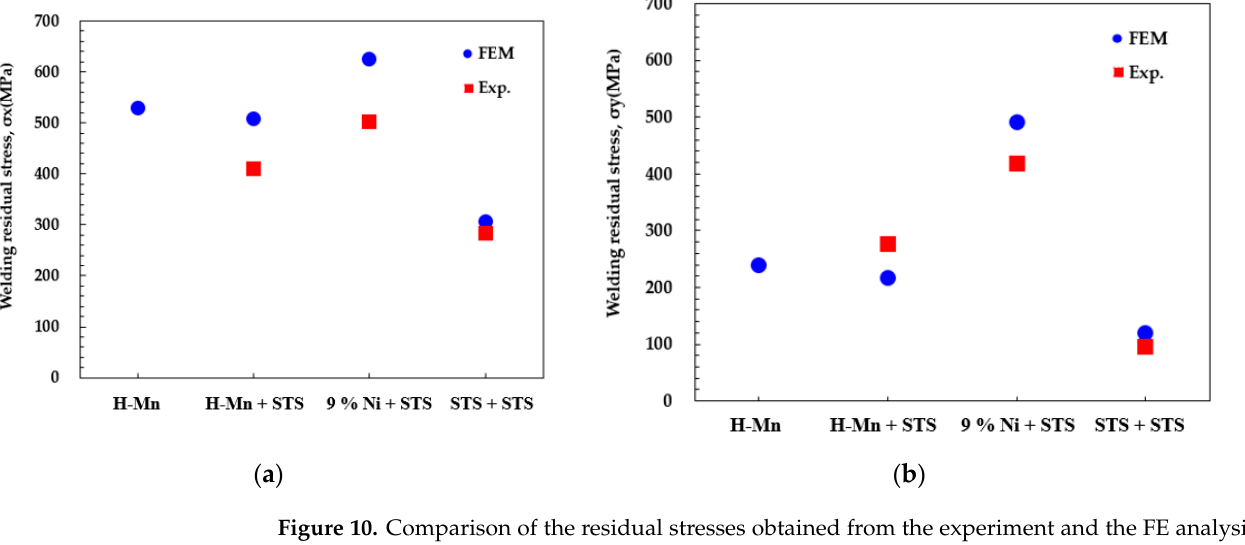
Figure 10. Comparison of the residual stresses obtained from the experiment and the FE analysis: ( a ) weld line-direction stress, i.e., σ x , and ( b ) transverse-direction stress, i.e., σ y .